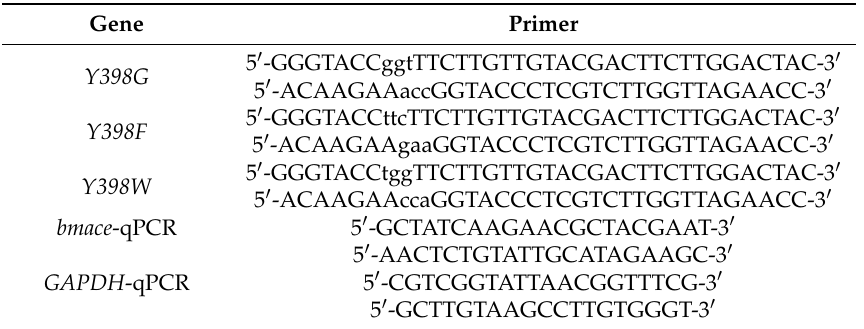
Figure 11. ( A ) Y398 mutants. The r Bm AChE II backbone is represented as a green ribbon; Y398, Y398G, Y398F, Y398W side chain carbons are shown by sticks in green, yellow, cyan, and magenta, respectively; red stick in Y398 refers to the phenolic hydroxyl group, dark blue in Y398W refers to the secondary amine; and ( B ) Pocket size. Bottleneck residues were presented in sticks, and pocket size is shown in contour surfaces. Table 2. Pair of primers to mutagenize codon 398 and primers for quantitative PCR of Bm ace and